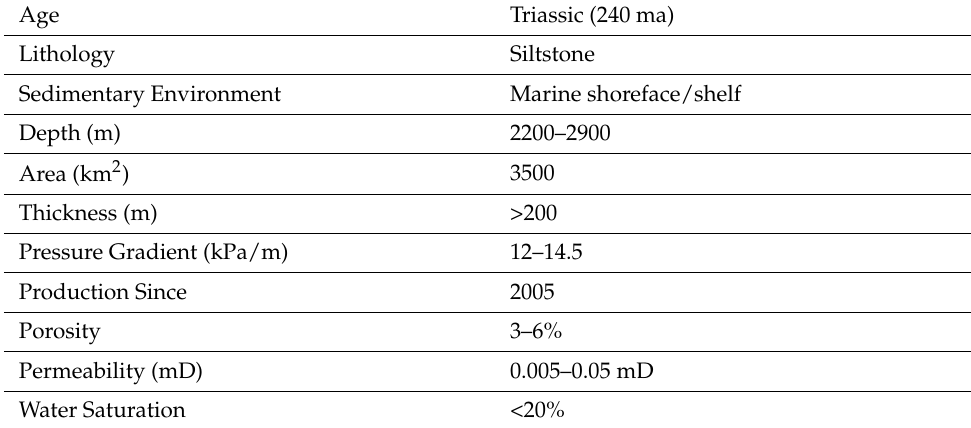
Figure 6. Wapiti Montney engineering information: ( a ) stimulated length (m); ( b ) injection rate (m 3 /min); ( c ) proppant per SL (kg /m); ( d ) fluid per SL (m 3 /min); ( e ) total stage count. Table 1. Wapiti Montney reservoir